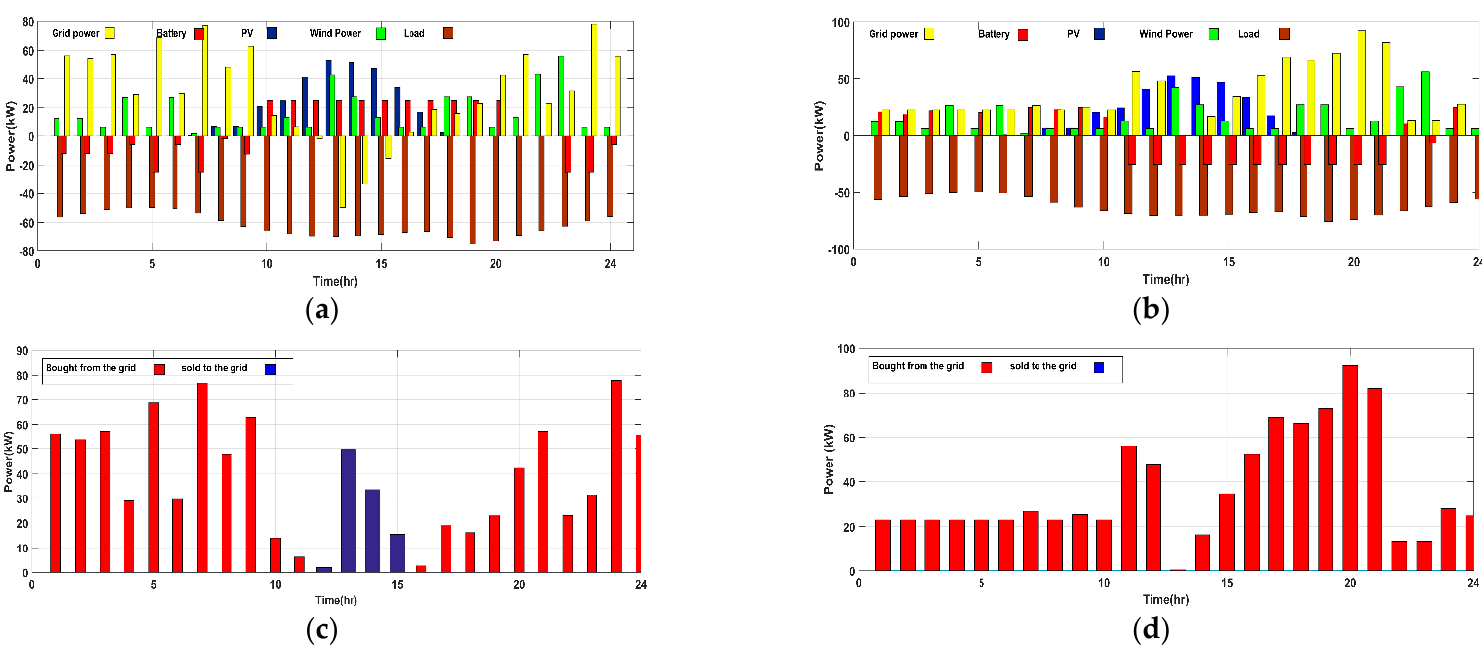
Figure 14. ( a , b ) Microgrid scheduled power flow with and without EMS respectively in case 2. ( c , d ) The purchased/sold power from the grid during the day with and without EMS.